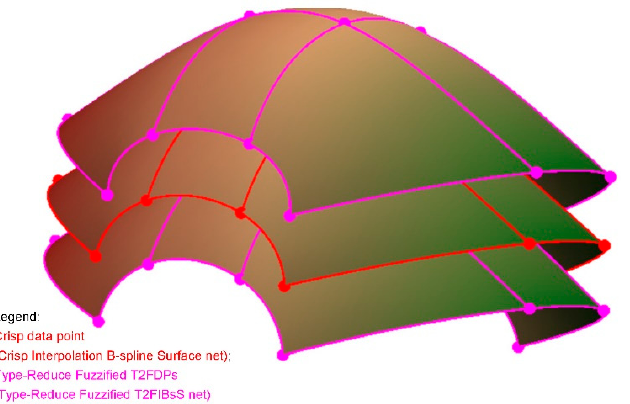
Figure 9. The example of type-reduced fuzzified T2FIBsS together with type-reduced fuzzified T2FDPs net.